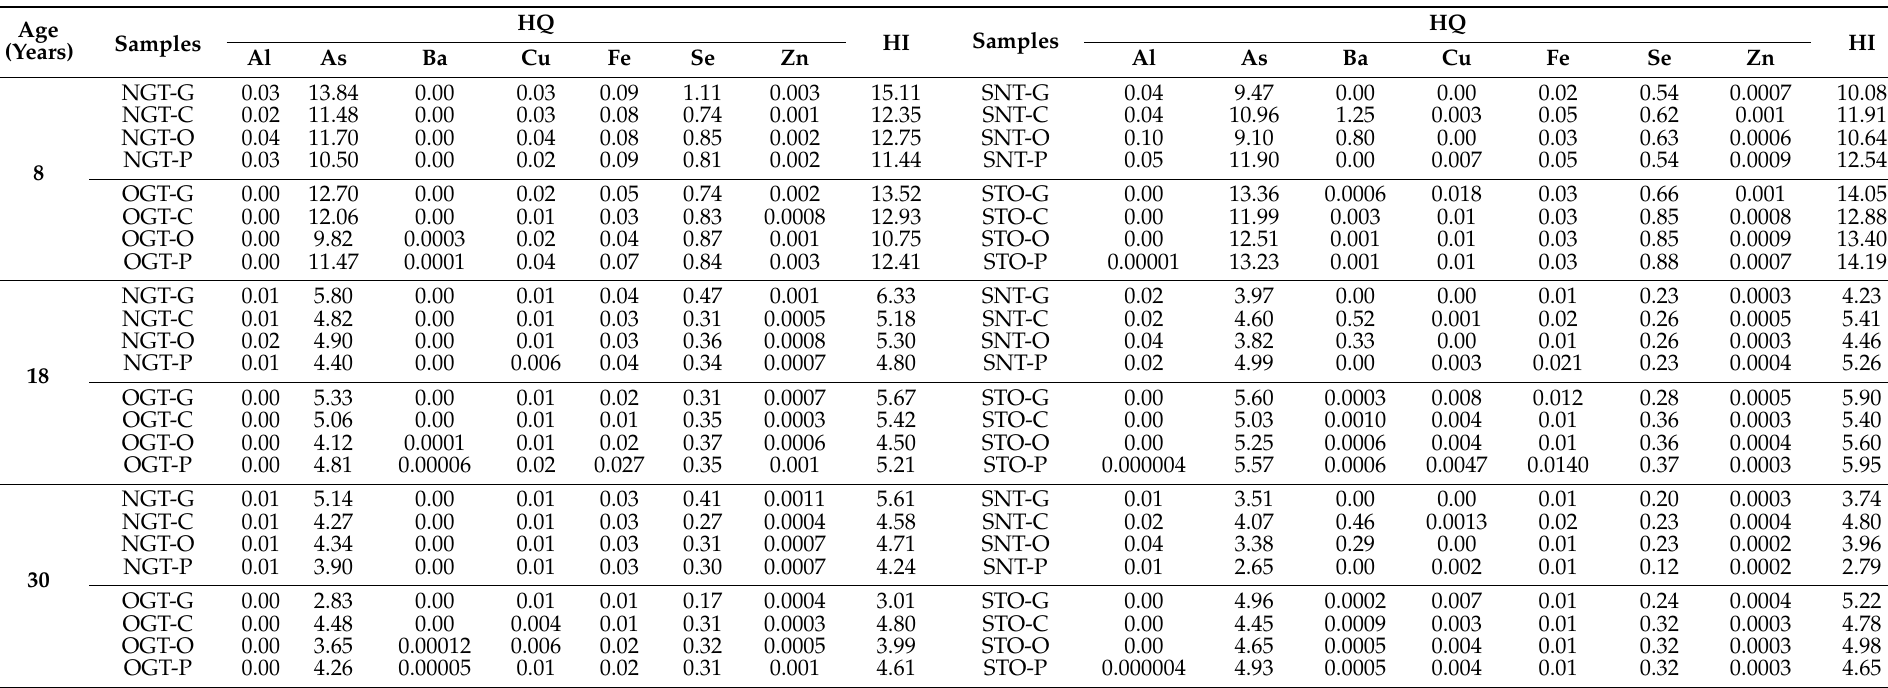
Table 3. Hazard quotient (HQ) and Hazard index (HI) due to the ingestion of canned tuna fish commercialized in Brazil for individuals aged 8, 18, and 30 years old. Age (Years)